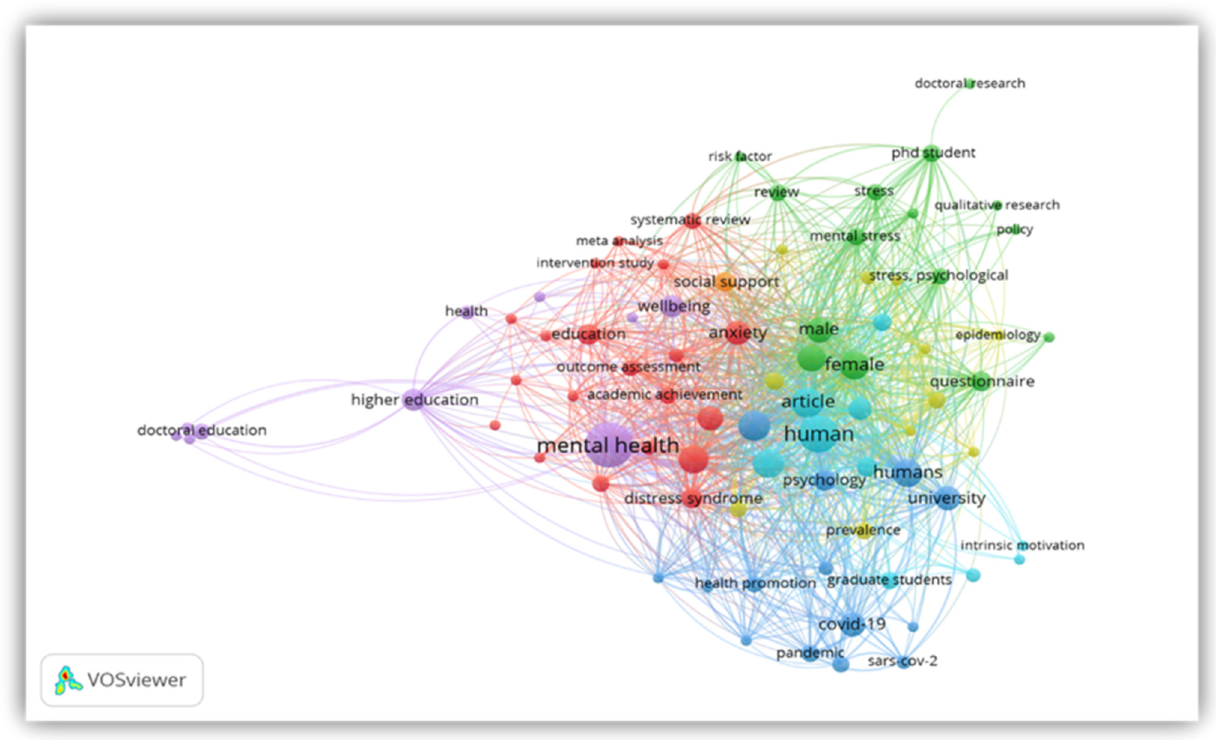
Figure 9. Network Visualization Map of Co-occurring